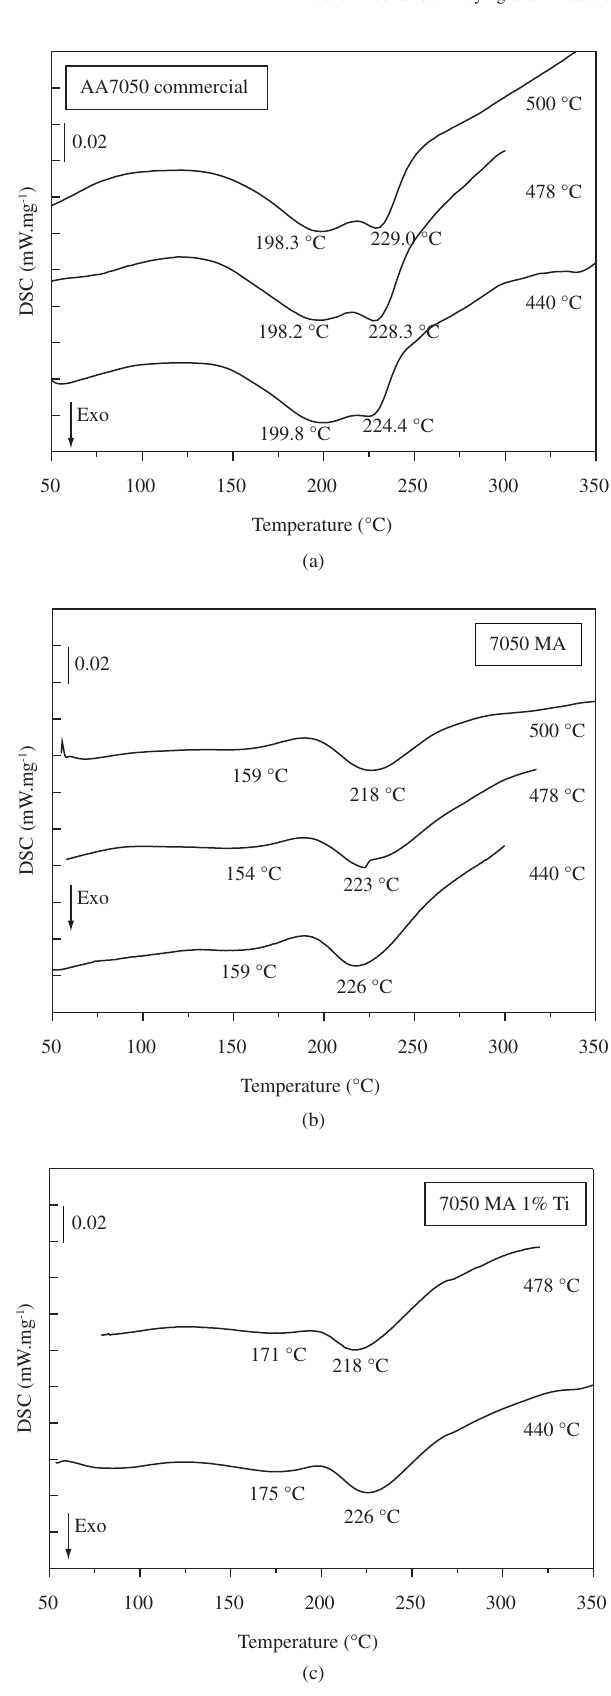
Figure 1. DSC curves of 7050 commercial, 7050 MA and 7050 MA1%Ti alloys after solution heat treatments at 440, 478 and 500 °C.